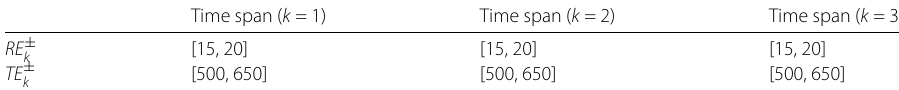
Table 5 Earnings (dollars) and capacity of the incinerator (in